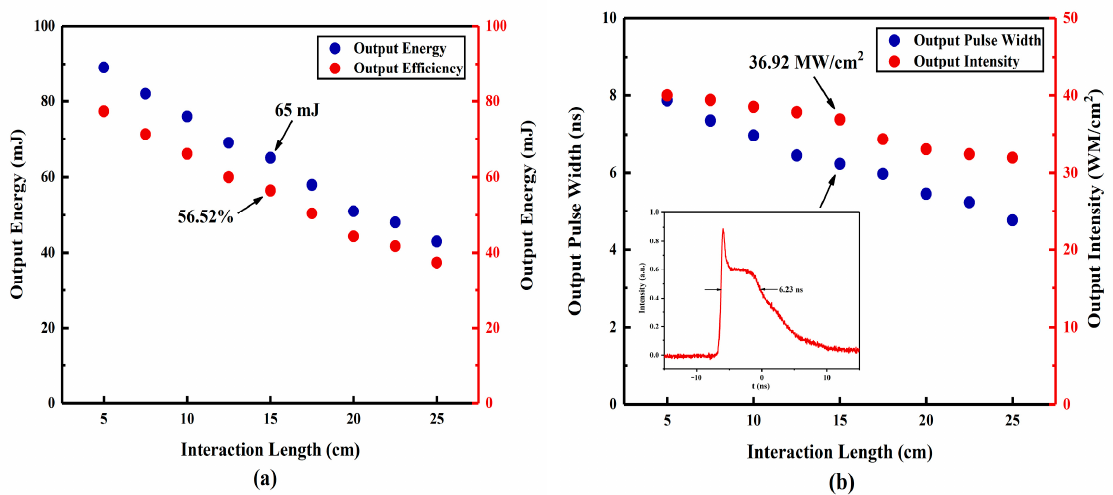
Figure 6. ( a ) Dependence of the output-step waveform energy and pump-to-step waveform energy efficiency on the interaction length between Stokes and the pump; ( b ) dependence of the output-step waveform pulse width and intensity on the interaction length between Stokes and the pump.